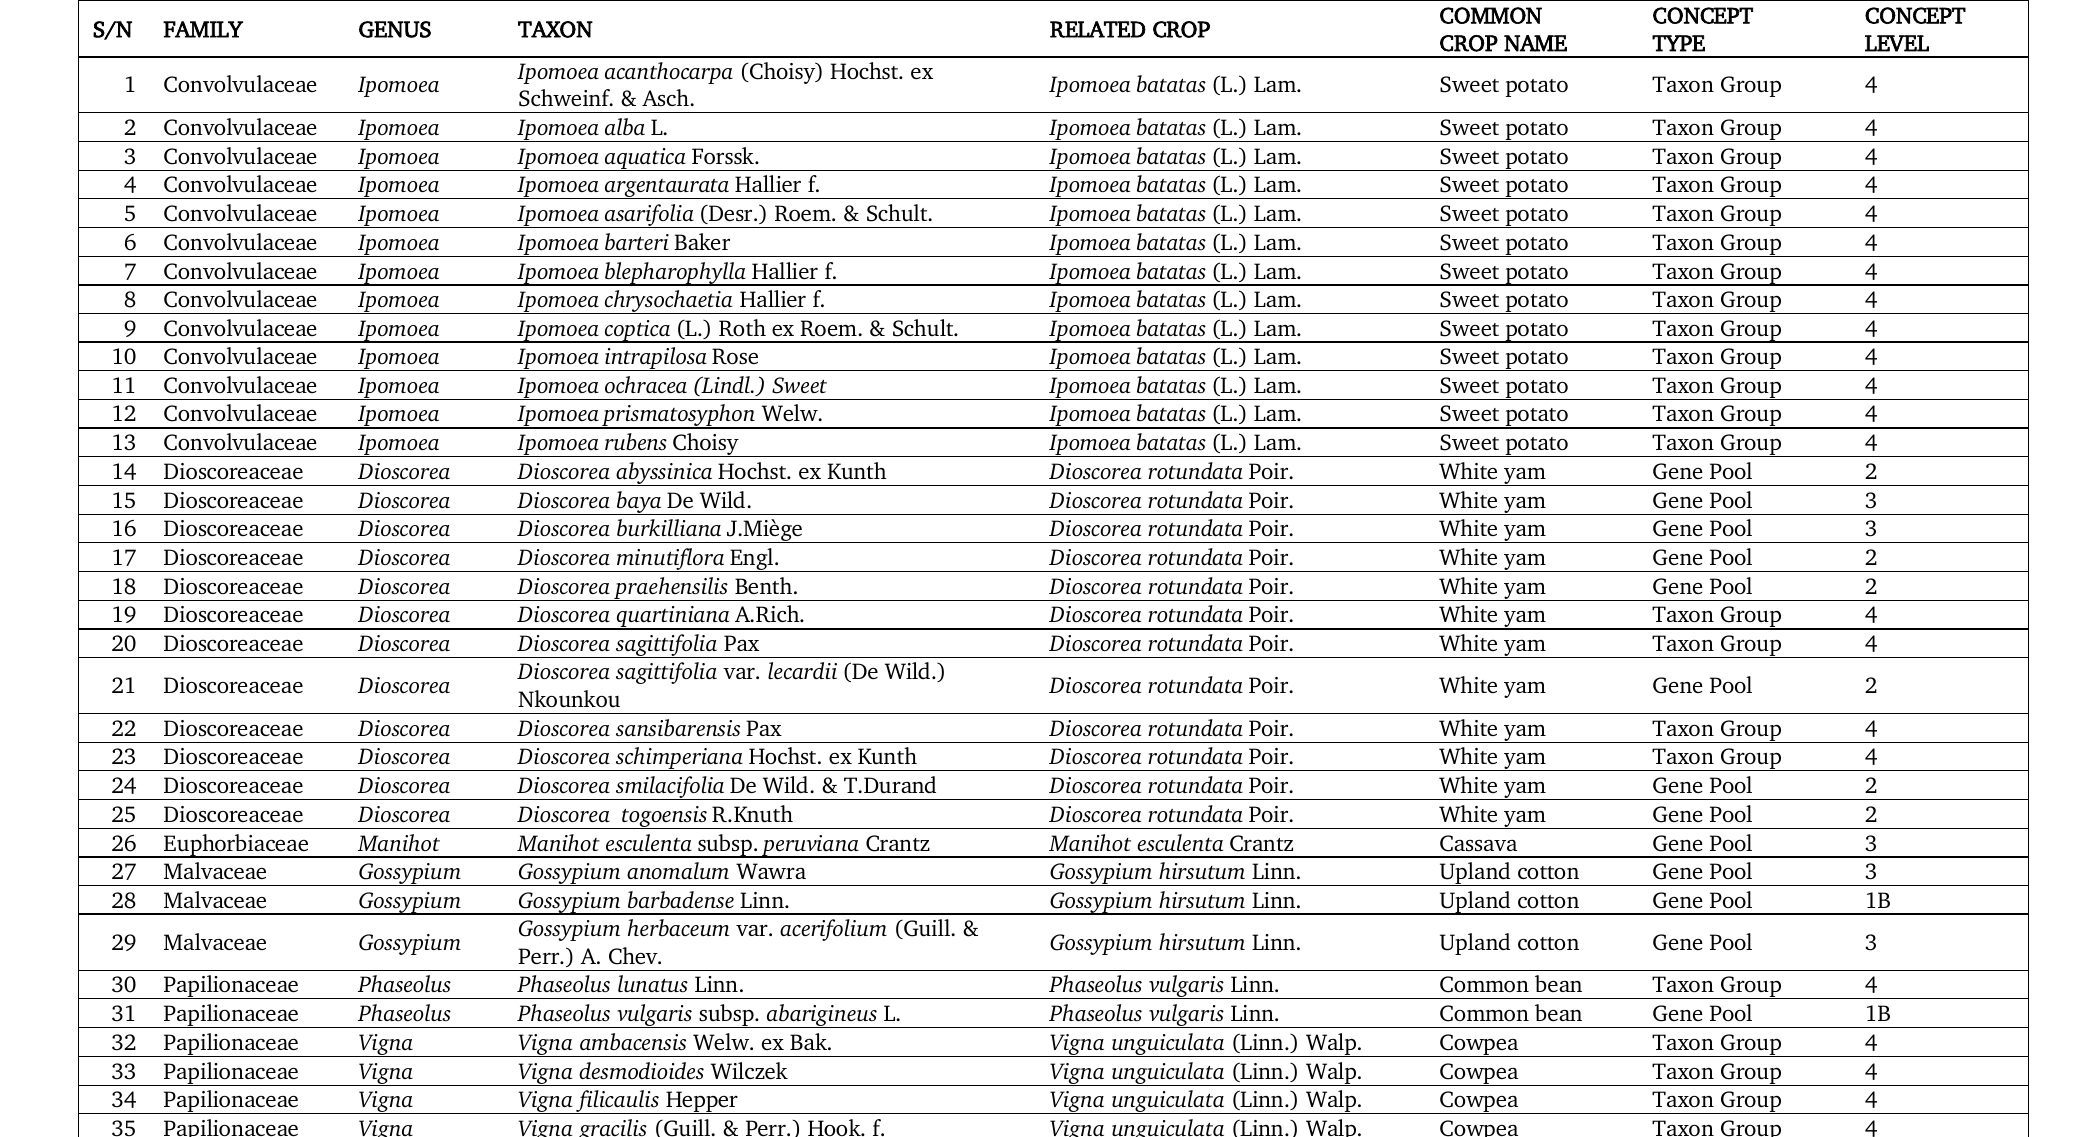
Supplemental Table S1 Related crop and concept level of priority CWR for West